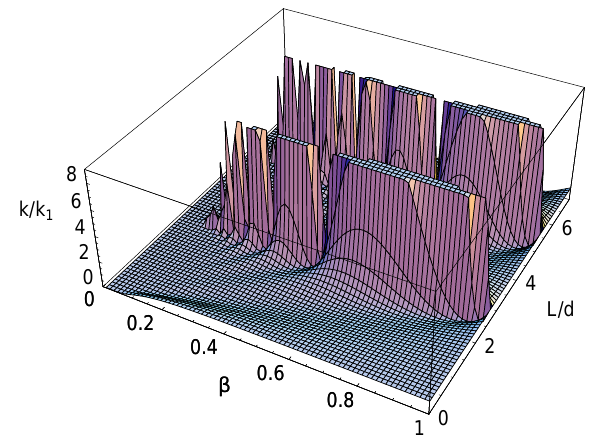
FIG. 1. (Color). The ratio of loss factors for a short bunch, s (cid:121) (cid:100) (cid:173) (cid:48)(cid:46)(cid:48)(cid:53) , versus b and resonator aspect ratio (cid:76) (cid:121) (cid:100) . The upper line in (cid:104) (cid:180) (cid:180) (cid:180) (cid:106) corresponds to even (cid:112) and the lower one to odd (cid:112) .